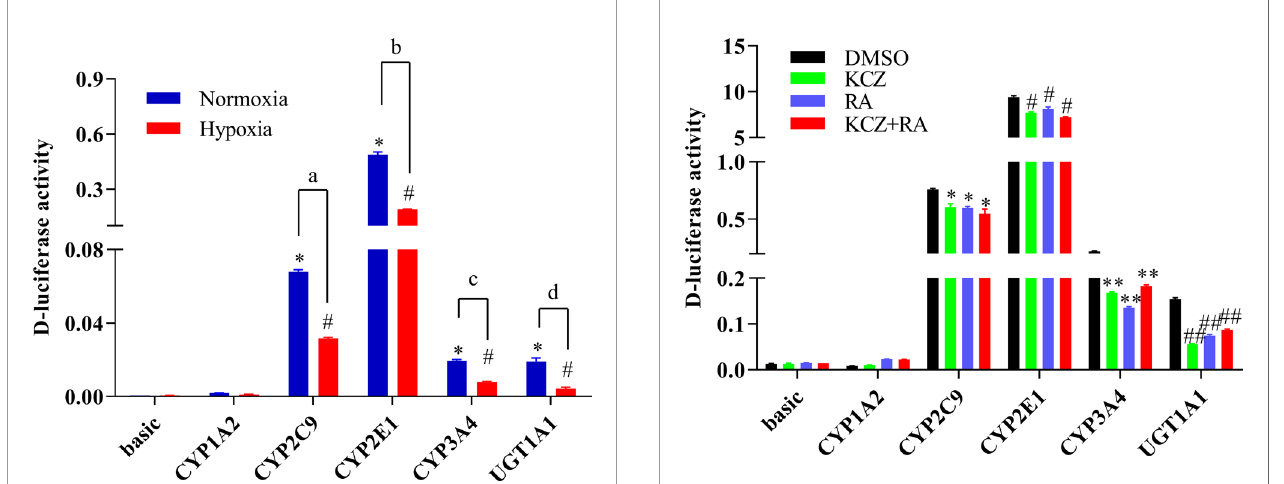
FIGURE 7 | The promoter activity of CYP1A2, CYP2C9, CYP2E1, CYP3A4, and UGT1A1 under hypoxic conditions. The HepG2 cells were transfected with pGL3-CYP1A2, pGL3-CYP2C9, pGL3-CYP2E1, pGL3-CYP3A4, pGL3- UGT1A1, or empty vector. The HepG2 cells treatment with hypoxia (2% O 2 ) or normoxia (21% O 2 ) for 24 h after transfection. The data were analyzed using a one-way analysis of variance (ANOVA), and the differences between the means of two groups were compared using LSD tests. *,#,a,b,c,d indicates the signi fi cance of each of the experimental groups compared with that of the control. * p < 0.05 vs. normoxia basic; # p < 0.05 vs. hypoxia basic; a p < 0.05 vs. normoxia CYP2C9; b p < 0.05 vs. normoxia CYP2E1; c p < 0.05 vs. normoxia CYP3A4; d p < 0.05 vs. normoxia UGT1A1. Values were expressed as Mean ± SEM (n = 3). Levels are considered signi fi cant at * p <